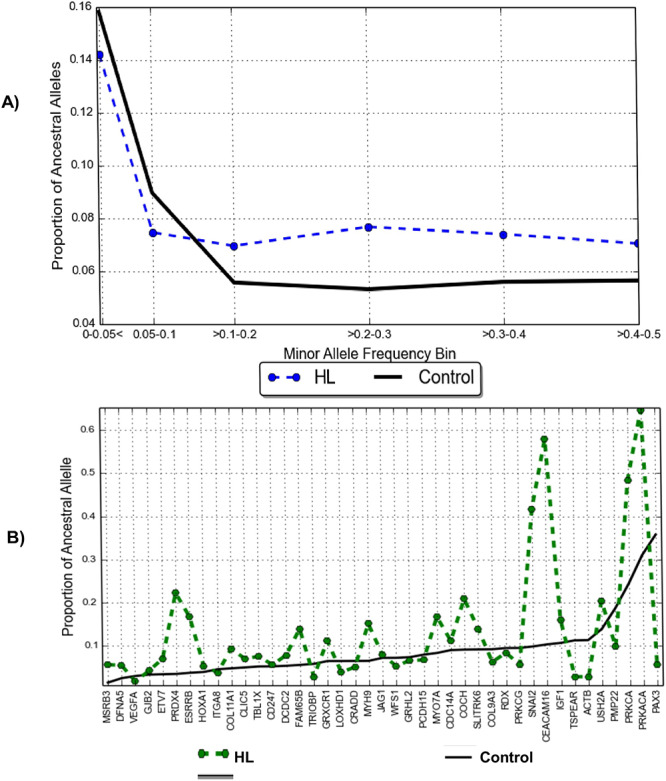
Proportion of ancestral alleles in the Cameroonian patients with HI and controls group. (A) Analysis indicates a higher proportion of ancestral alleles for rare variants (MAF of 0·00–0·1) in the controls groups as compared with the patients group. (B) Distribution of ancestral alleles proportion based on known HI genes. HL: Hearing Loss.